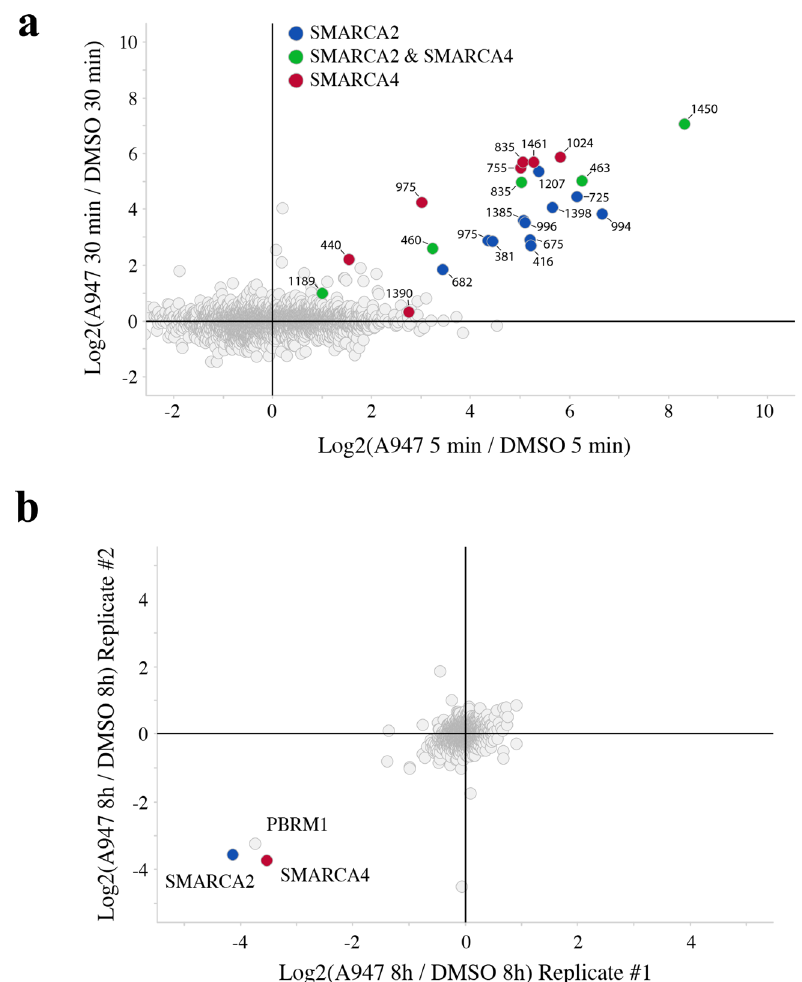
Fig.2|A947-mediatedubiquitinationanddegradationofSMARCA2/4.a Global ubiquitylome changes, as assessed by di-glycine reminant mass spectrometry pro fi ling, in SW1573 cells following treatment with 500nM A947 for 5 and 30min. n =5720 unique ubiquitinated peptides were identi fi ed and presented as log2 fold change relative to DMSO control cultures. Positions of ubiquitinated lysines in peptides that uniquely map to SMARCA2 (UniProtKB P-51531-1) or SMARCA4